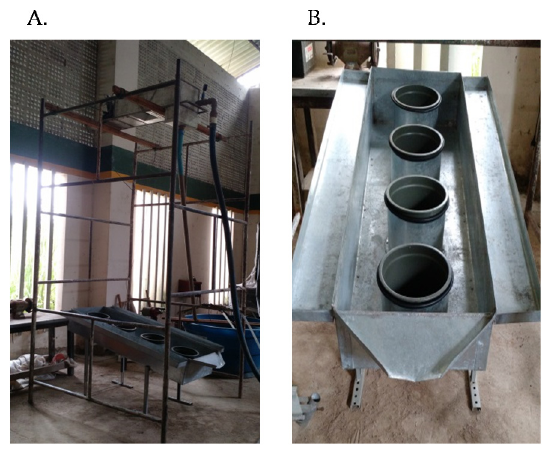
Figure 1. Photographs of the laboratory setup used in the experiments: ( A ) Rainfall simulator and corresponding support structure, and ( B ) Downstream view of soil flume with buffer zones.